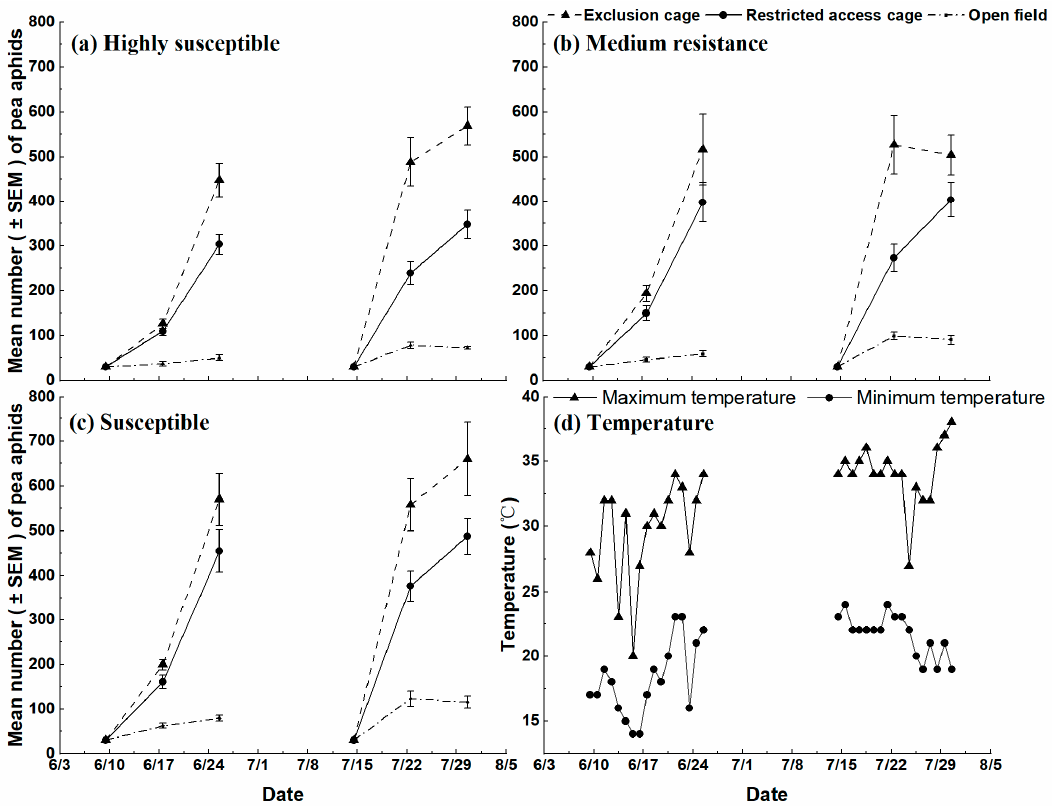
Figure 2. Population dynamics of pea aphid, Acyrthosiphon pisum , showing the mean aphid number (±SEM) on nine different alfalfa cultivars and assigned to three cultivar classes ( a ) highly susceptible, ( b ) medium resistance and ( c ) susceptible) under field conditions in Ningxia Province, China, in 2019. ( d ) The daily maximum (triangle) and minimum (circle) temperatures recorded during the experiment.